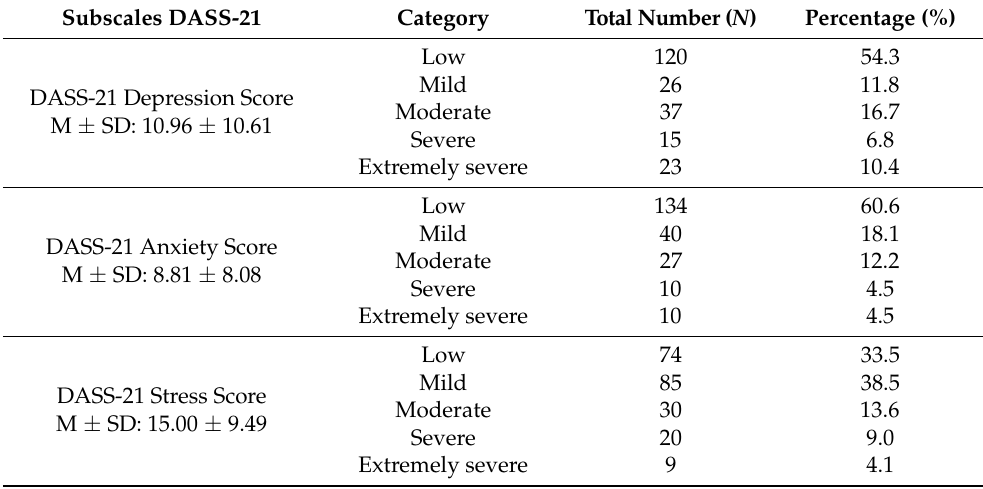
Table 3. Depression, Anxiety, and Stress Scale—21 items (DASS-21) final